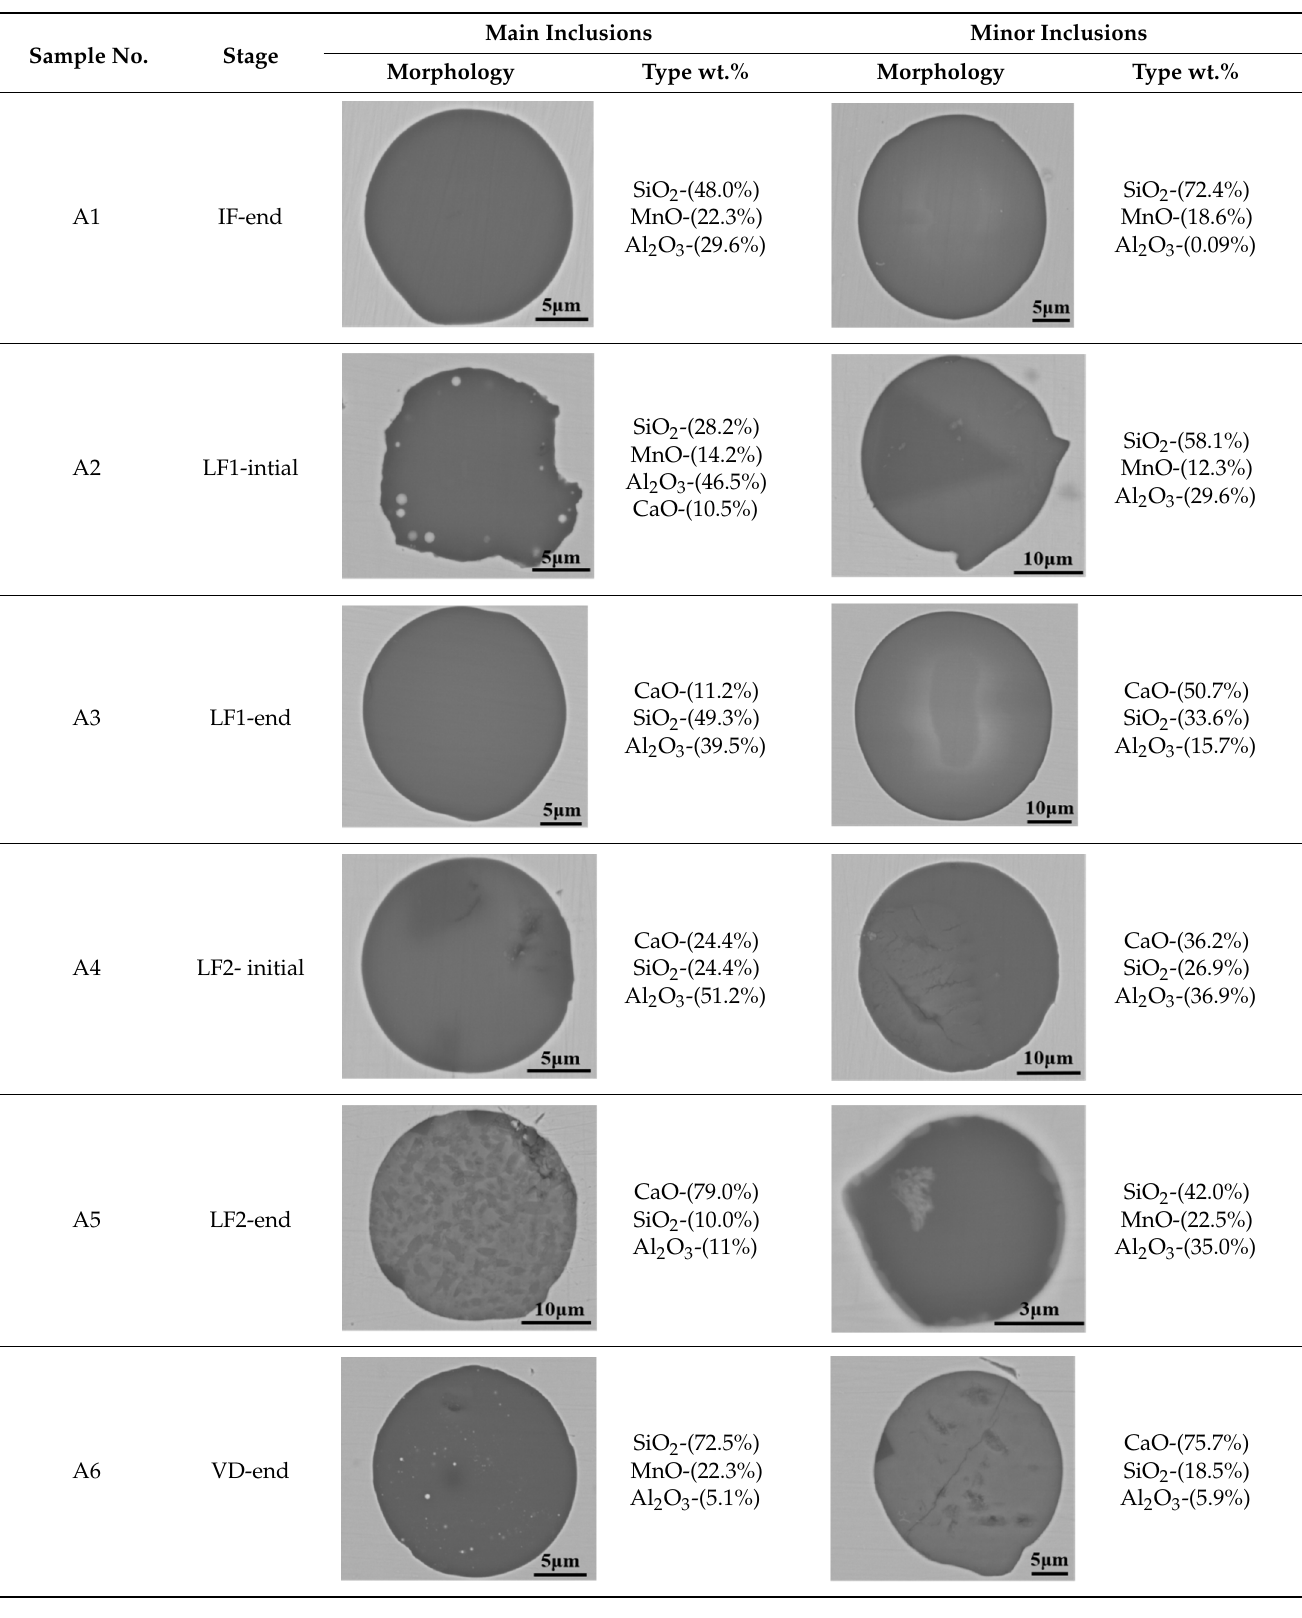
Table 3. Morphology and composition (in mass%) of typical large-size inclusions at different stages (Specimen A1–A8).